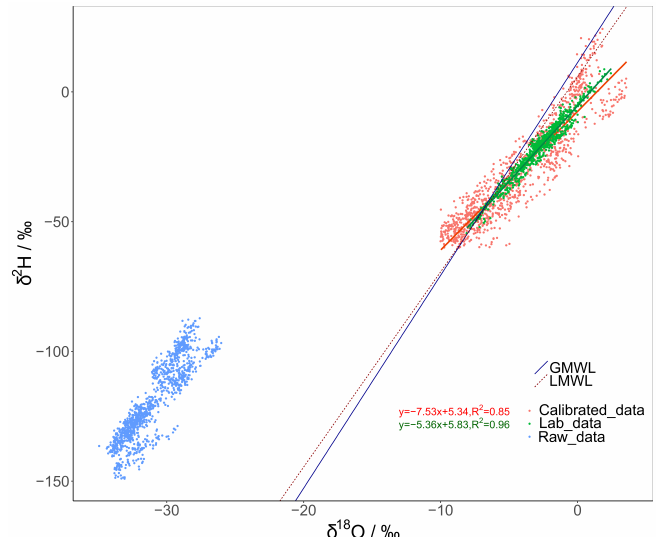
Figure 3. Dual ( δ 18 O, δ 2 H) isotope plot, which represents the uncalibrated raw data, calibrated data from the system, and lab data (manually taken samples, analyzed in Giessen, Germany) in comparison to the local meteoric water line (LMWL) and global meteoric water line